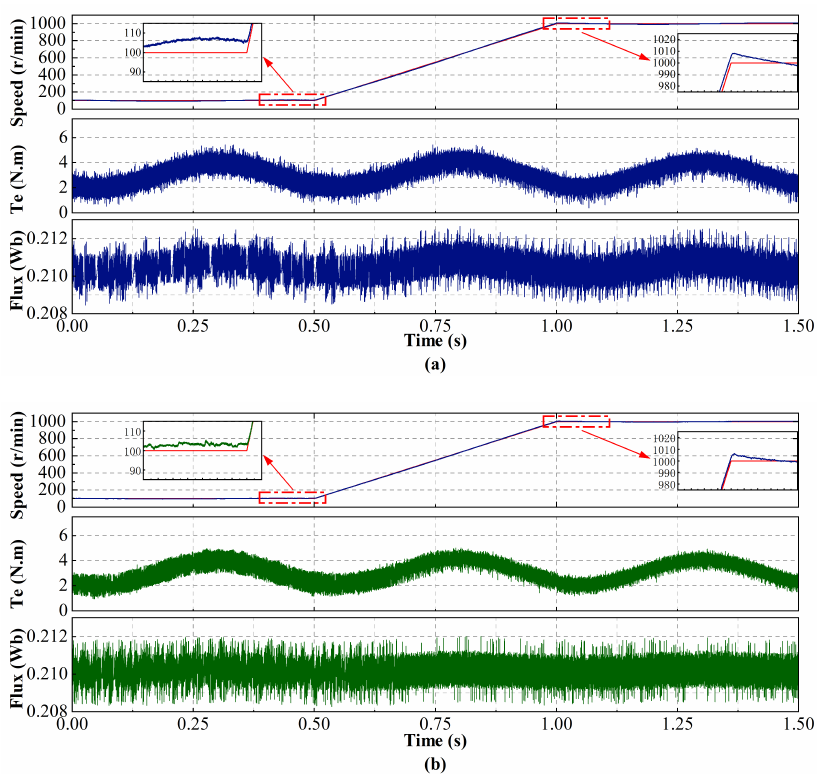
Figure 5. The simulation results of conventional PPTC and proposed MF-PPTC with mismatched parameters. ( a ) Conventional PPTC. ( b ) Proposed